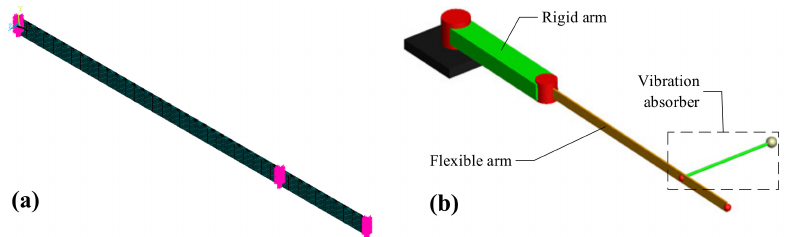
Figure 9. Simulation model of flexible manipulator: ( a ) the flexible arm model in ANSYS; ( b ) the flexible manipulator model with vibration absorber in ADAMS.